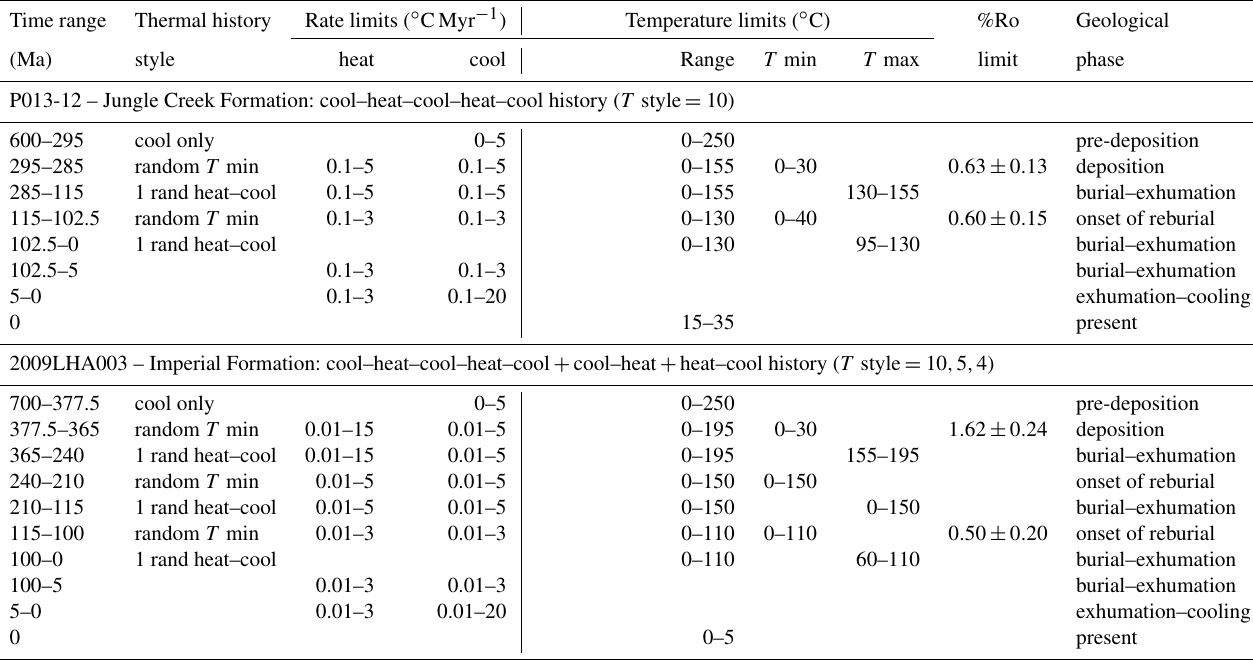
Table 4. Model boundary conditions and constraints for two AFT